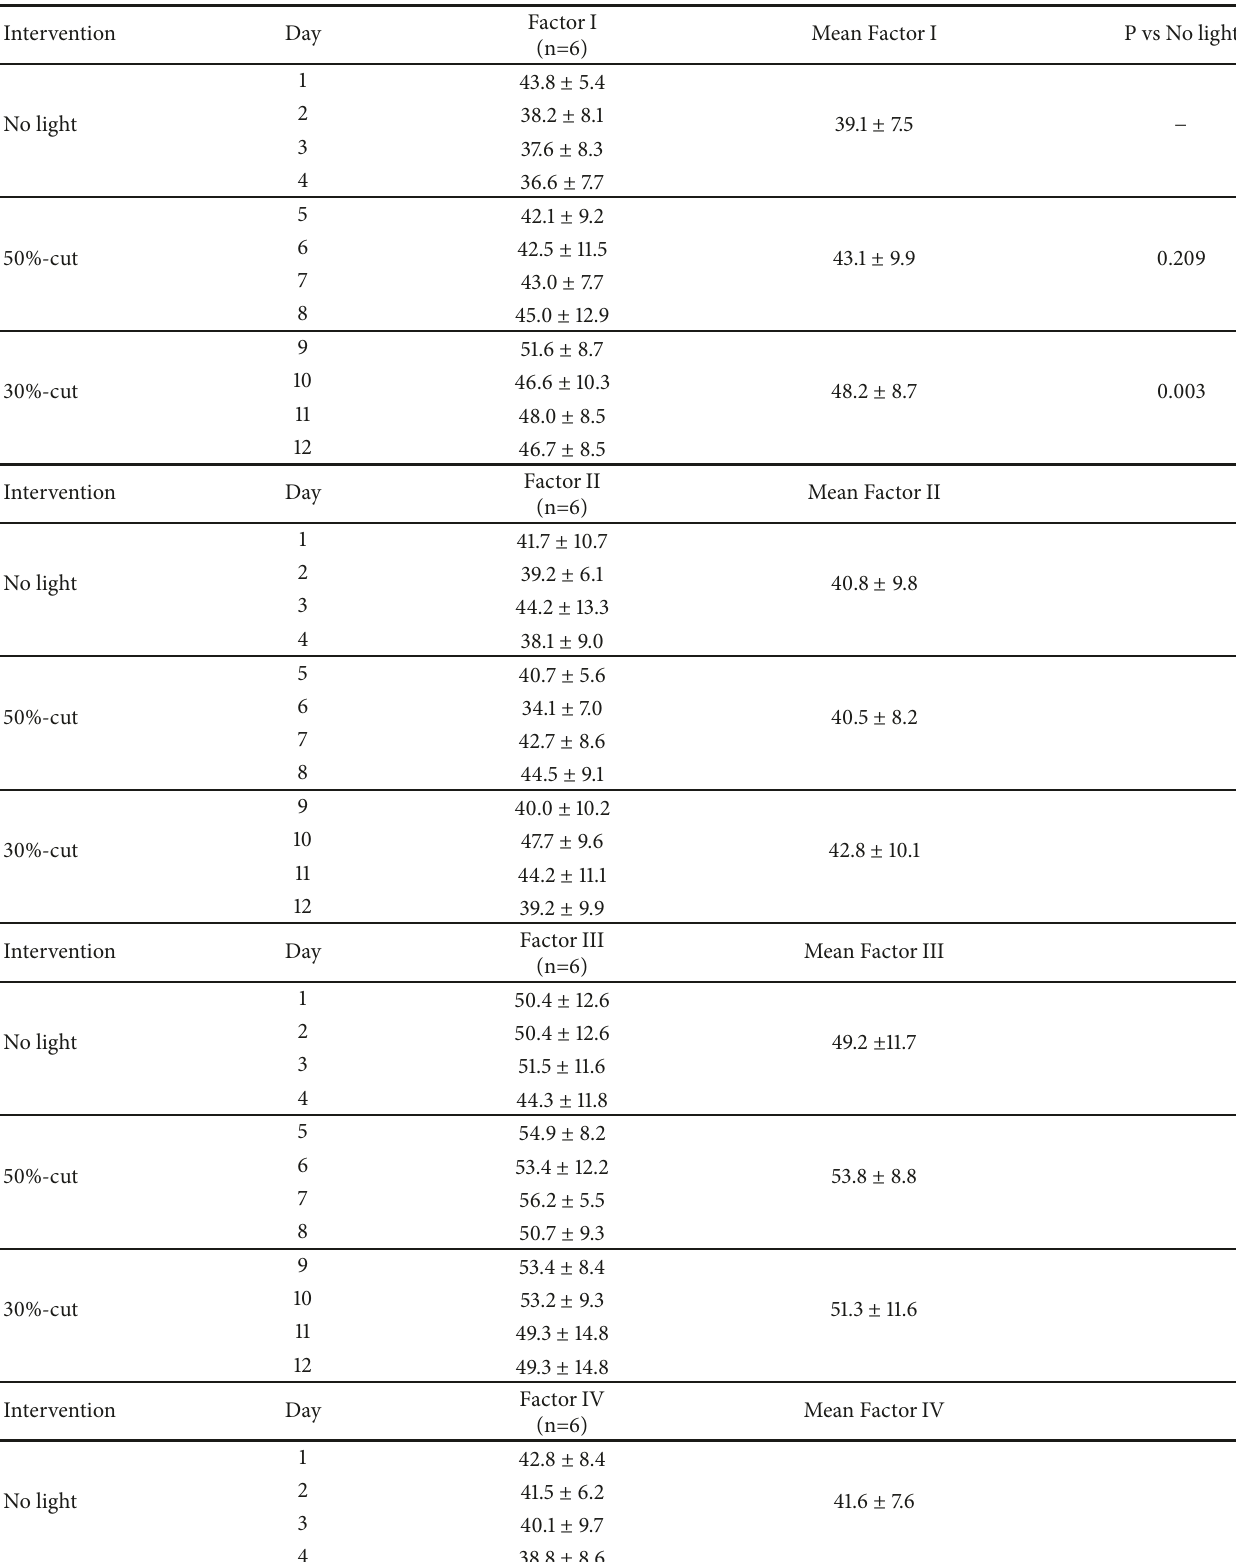
Table 2: Effects of the interventions on the mean scores for Oguri–Shirakawa–Azumi sleep inventory factors I to V. Factor I is “sleepiness on rising,” factor II “initiation and maintenance of sleep,” factor III “frequent dreaming,” factor IV “refreshing,” and factor V “sleep length.” Data are presented as mean ±